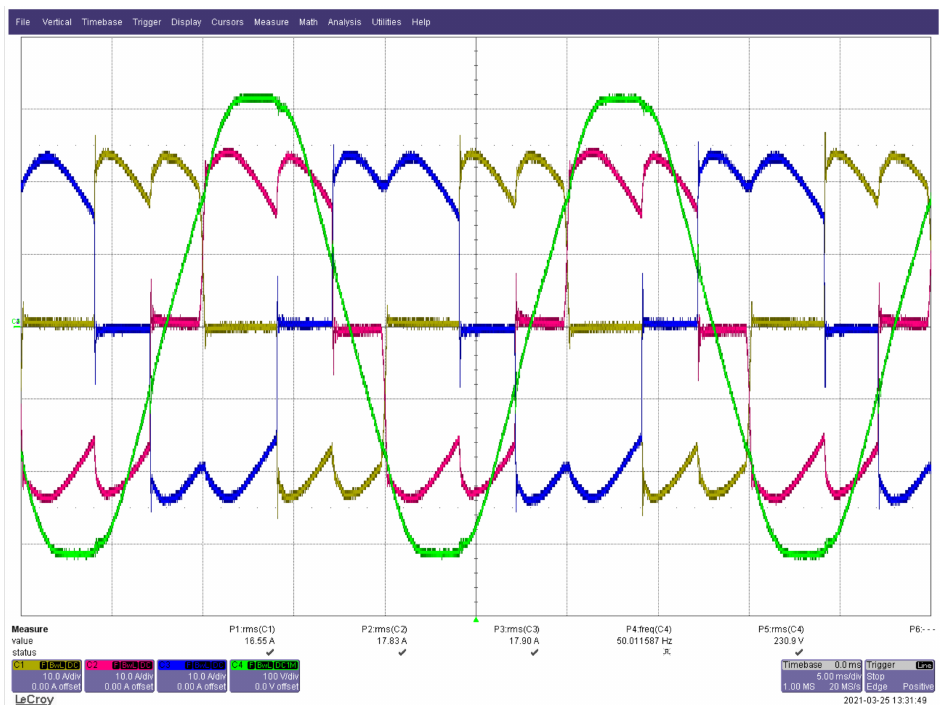
Figure 14. Exemplary experimental waveforms for fully controlled rectifier, load currents i L1 ( t ) (red), i L2 ( t ) (blue), i L3 ( t ) (yellow), and line voltage u M1 ( t ) (green).